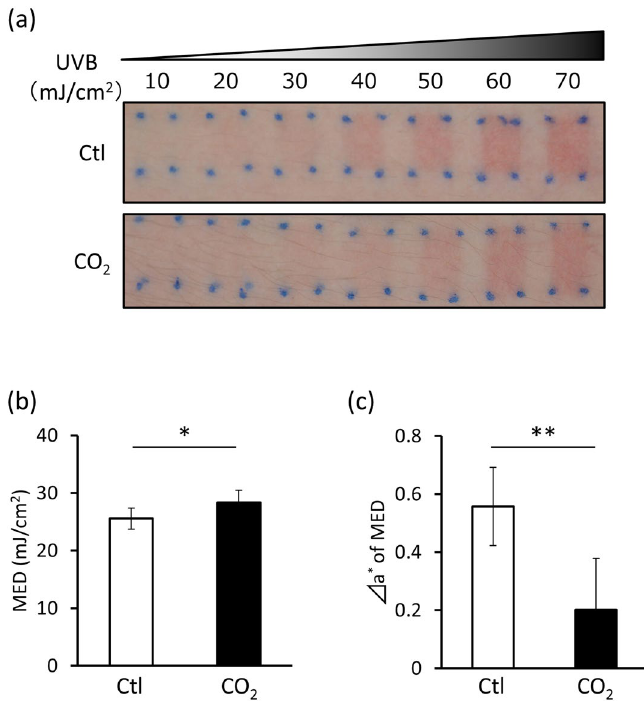
Figure 4. CO 2 inhibits UVB-induced erythema in human skin. CO 2 -free (Ctl) and high-CO 2 concentration (CO 2 ) formulations were applied to the skin of the inner upper left arm twice daily for 2 weeks and then exposed to UVB. The next day, ( a ) UVB-irradiated skin images were obtained. The images shown are representative